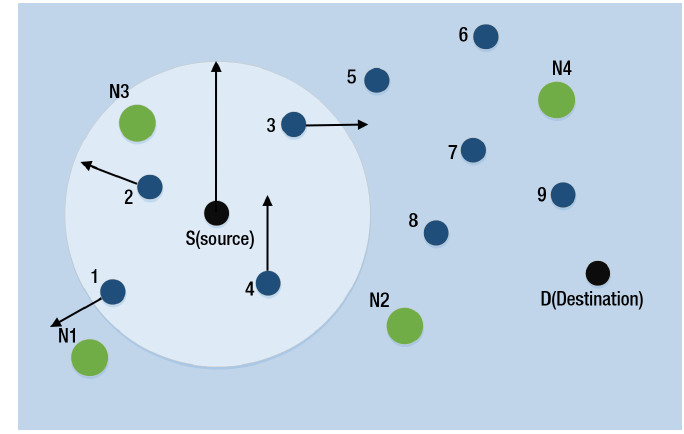
Figure 9. Data transmission in Location-Aware Routing Protocol (LARP)